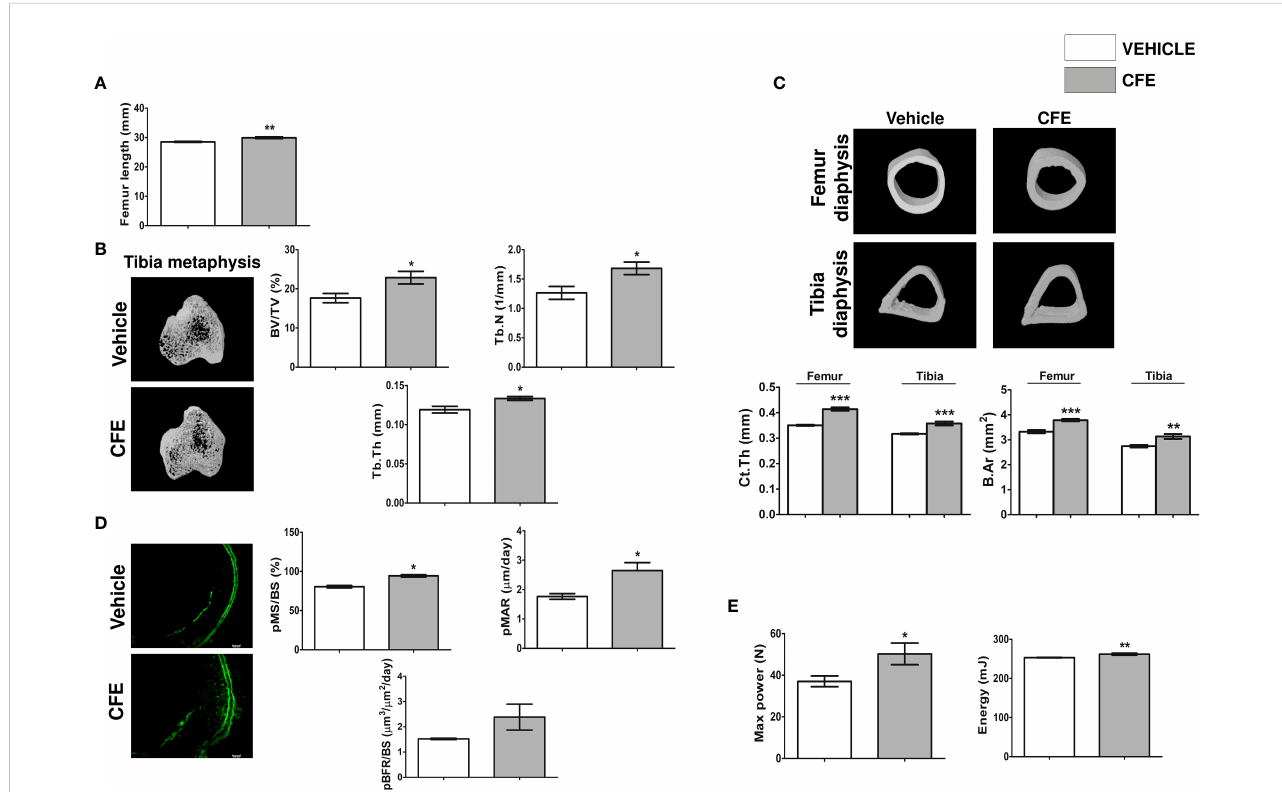
FIGURE 2 CFE promoted new bone formation in growing rats. (A) Femur length. (B) Representative m CT images (left panel) and quantitative m CT parameters of the tibia metaphysis (right panel). %BV/TV, percent bone volume per tissue volume; Tb.N, trabecular number; Tb.Th, trabecular thickness. (C) Representative m CT images (upper panel) and quantitative m CT parameters of the femur and tibia diaphysis (lower panel). Ct.Th, Cortical thickness and B.Ar, bone area. (D) Left panel showing the representative images of double calcein labeling (scale bar, 100 µm) and histomorphometry parameters (right panel) of the indicated groups. (E) 3-point bending strength of femur was determined by a bone-strength tester. All data are expressed as mean ± SEM (n = 6 bones/ group); *p <0.05, **p <0.01, and ***p<0.001 vs. vehicle-treated